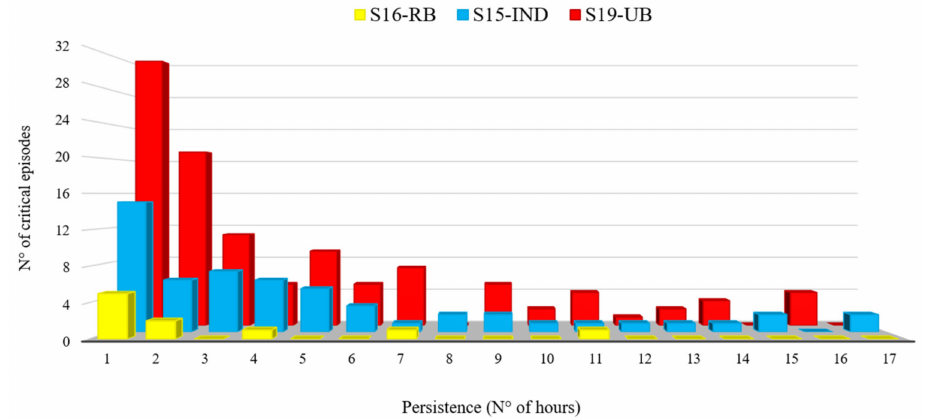
Figure 7. Number of critical episodes and their persistence (i.e., number of consecutive 1-h PM 10 concen- trations > 90 µ g m − 3 ) for S15-IND, S16-RB, S19-UB stations for the period 28 June 2018–15 April